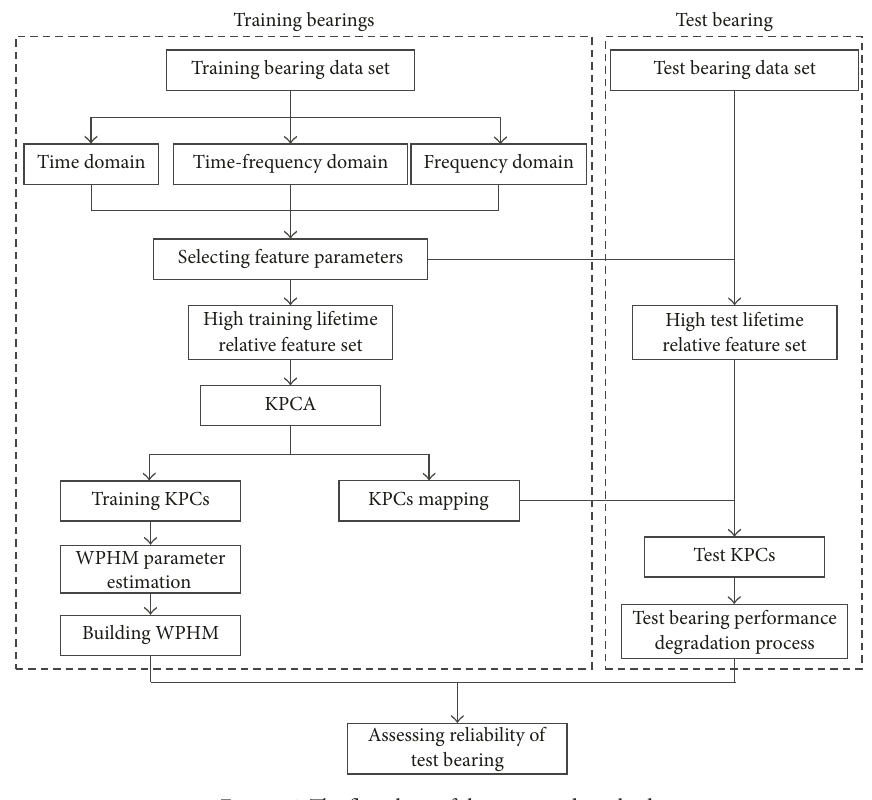
Figure 1: The flowchart of the proposed method.